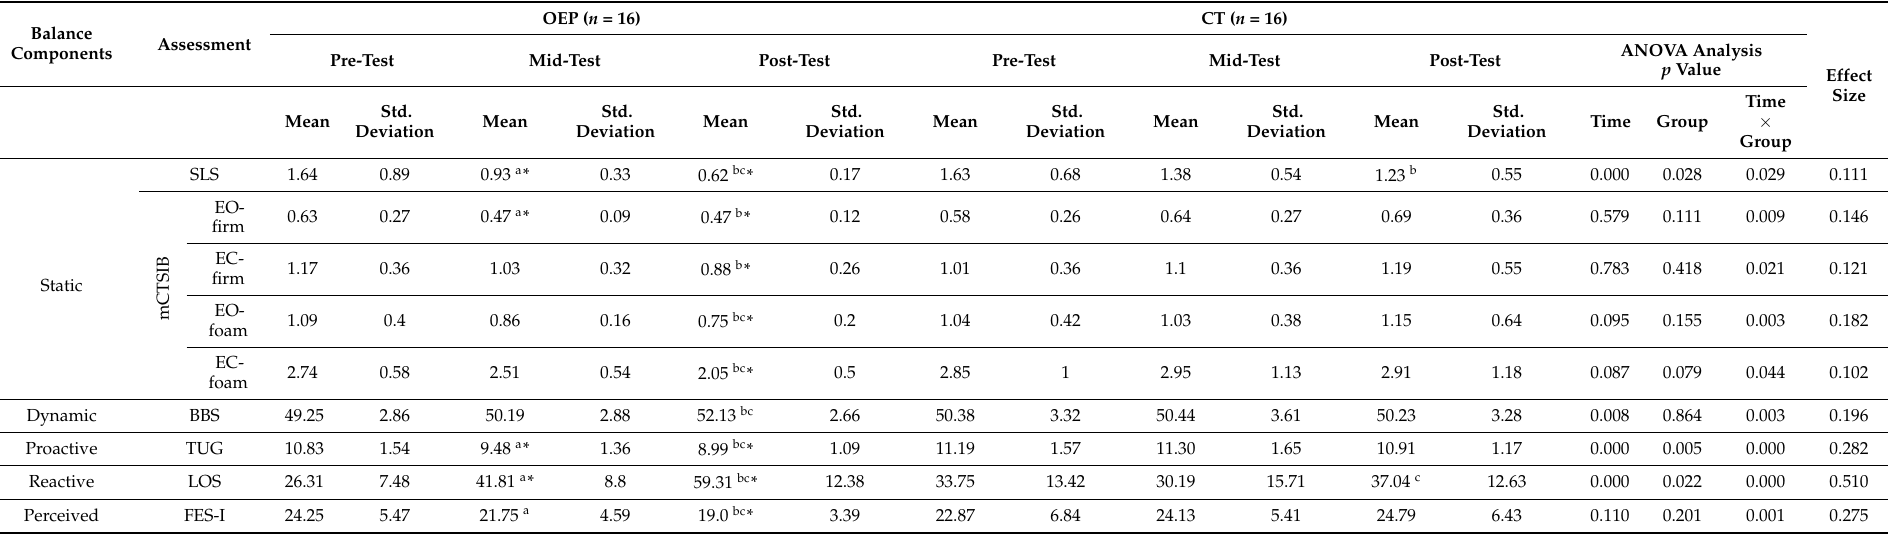
Table 3. Effect of the Modified-OEP on balance